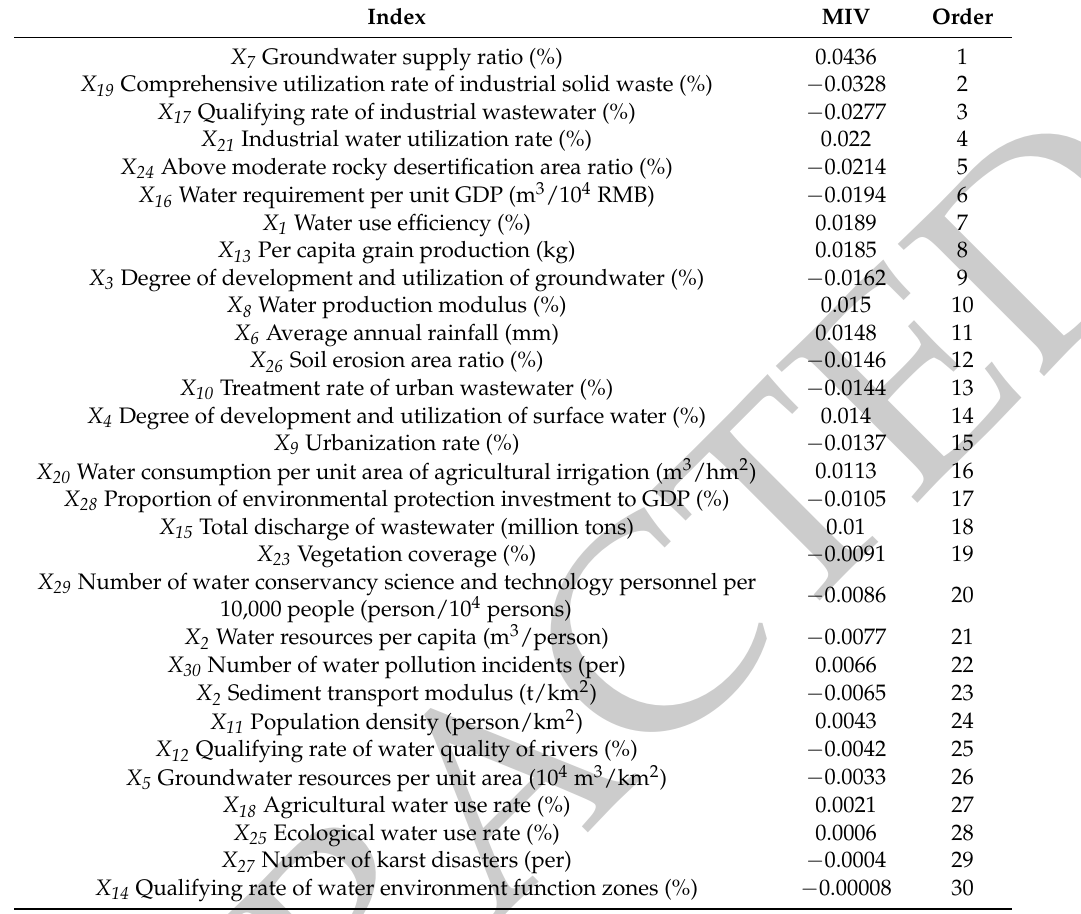
Table 2. Mean impact values (MIVs) of water resource security influence factors in the karst area. Index MIV